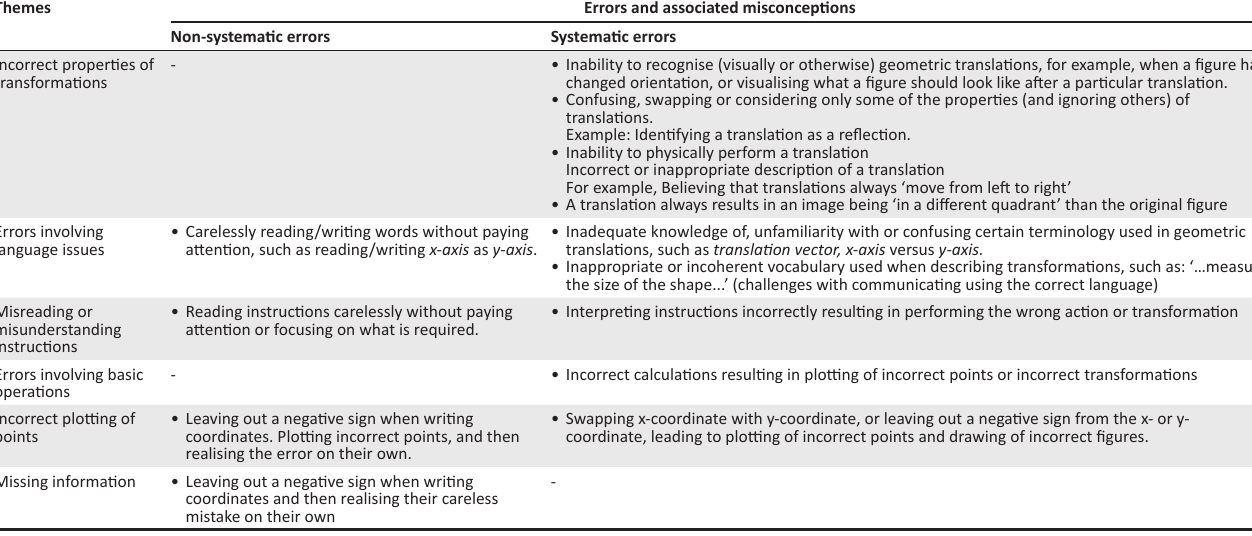
TABLE 3: Themes generated from the analysis of tests and interviews to answer research question 1. Themes